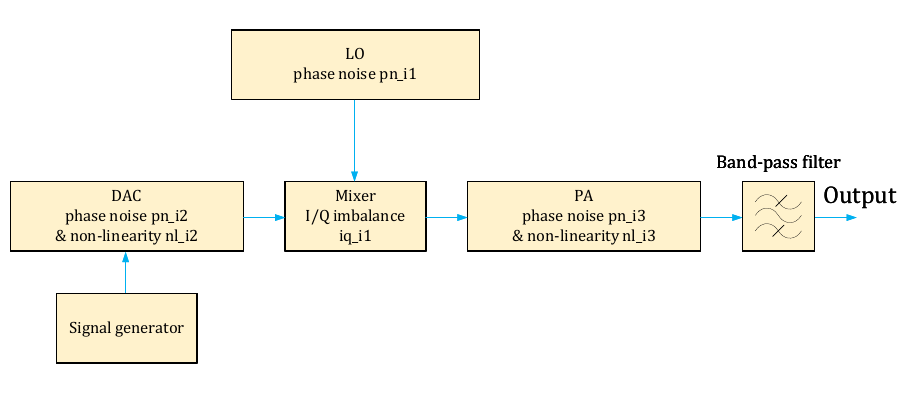
Figure 7. The diagrams of an equivalent model for GNSS and spoofer transmitter. In GNSS trans- mitters, all distortions are indexed with s*; in a spoofer transmitter, all distortions are indexed with